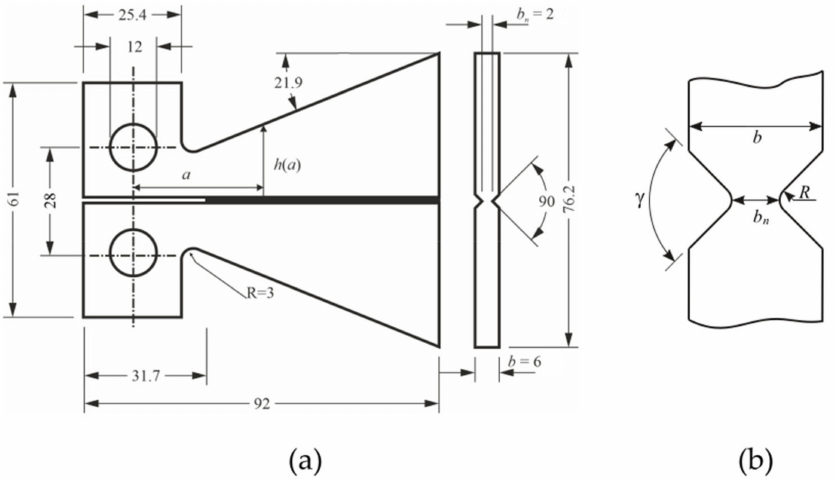
Figure A1. The geometry of the TDCB specimen with dimensions in millimeters ( a ) and a detailed view of the grooved section of the specimen ( b